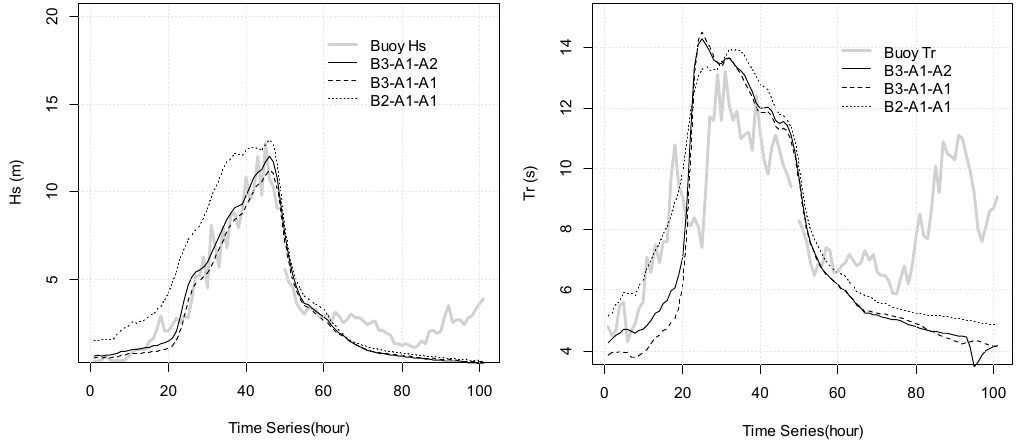
Figure A9. Comparison of typhoon waves induced by Typhoon Meranti (14-2016) at buoy Taitung: the standard H10 is indexed as B2-A1-A1, the model with varying parameter b without an asymmetric typhoon structure is indexed as B3-A1-A1, and MH10 is indexed as B3-A1-A2.